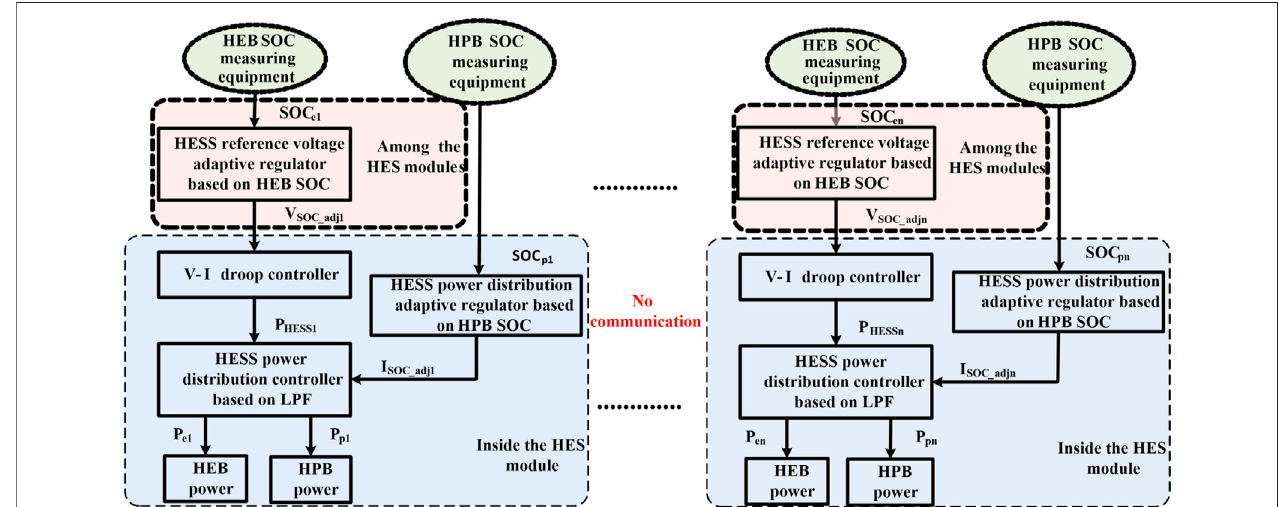
FIGURE 3 | The overall architecture of multi-HESS collaborative control